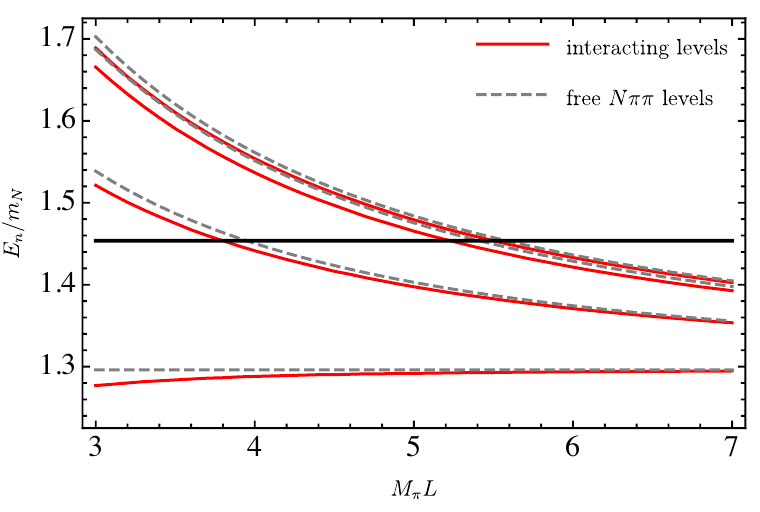
Figure 4 . Roper energy levels for different box sizes L considering only nucleon and σ -dimer as intermediate states. Red solid lines display the numerical results for the interacting energy levels and grey dashed lines the free (non-interacting) lowest-lying three-particle Nππ energy levels. The thick solid black line marks the mass of the Roper